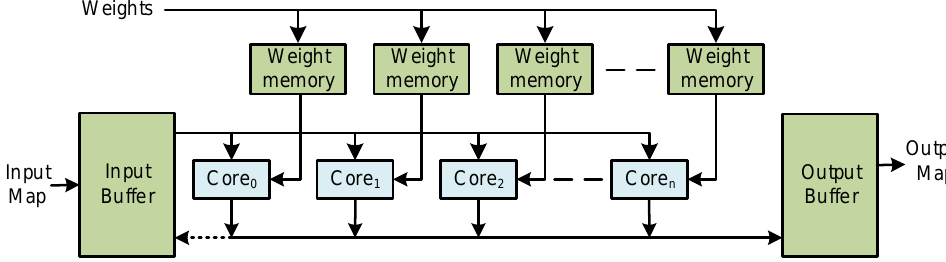
Figure 2. Architectural structure of the main modules of the hardware accelerator. The output buffer of the module for the first layer is shared with the input buffer of the module for the hidden layers. Furthermore, the input buffer of the module for the last layer is shared with the output buffer of the module for hidden layers (see Figure 3).